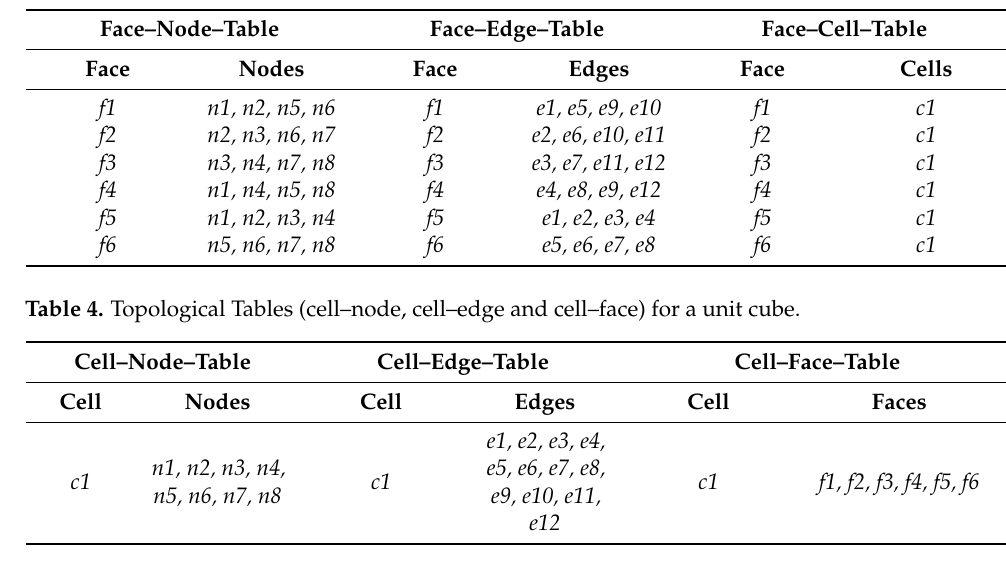
Table 3. Topological Tables (face–node, face–edge and face–cell) for a unit cube.